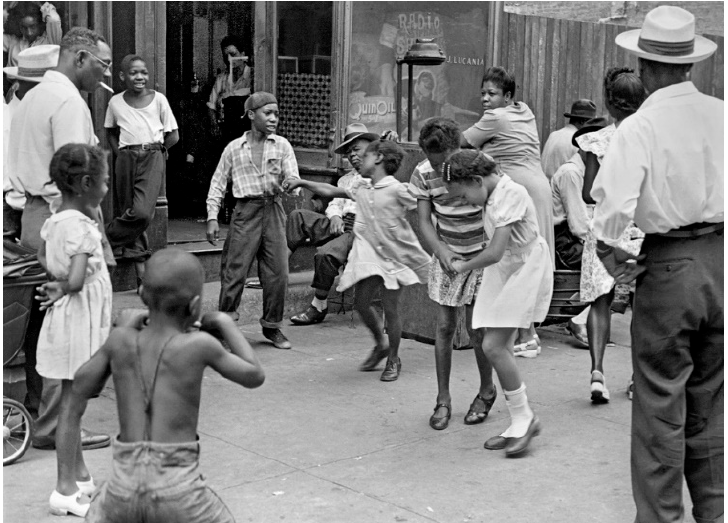
Figure 6. Helen Levitt, New York , c. 1940. © Helen Levitt Film Documents LLC. All rights reserved. Courtesy of Thomas Zander Gallery.